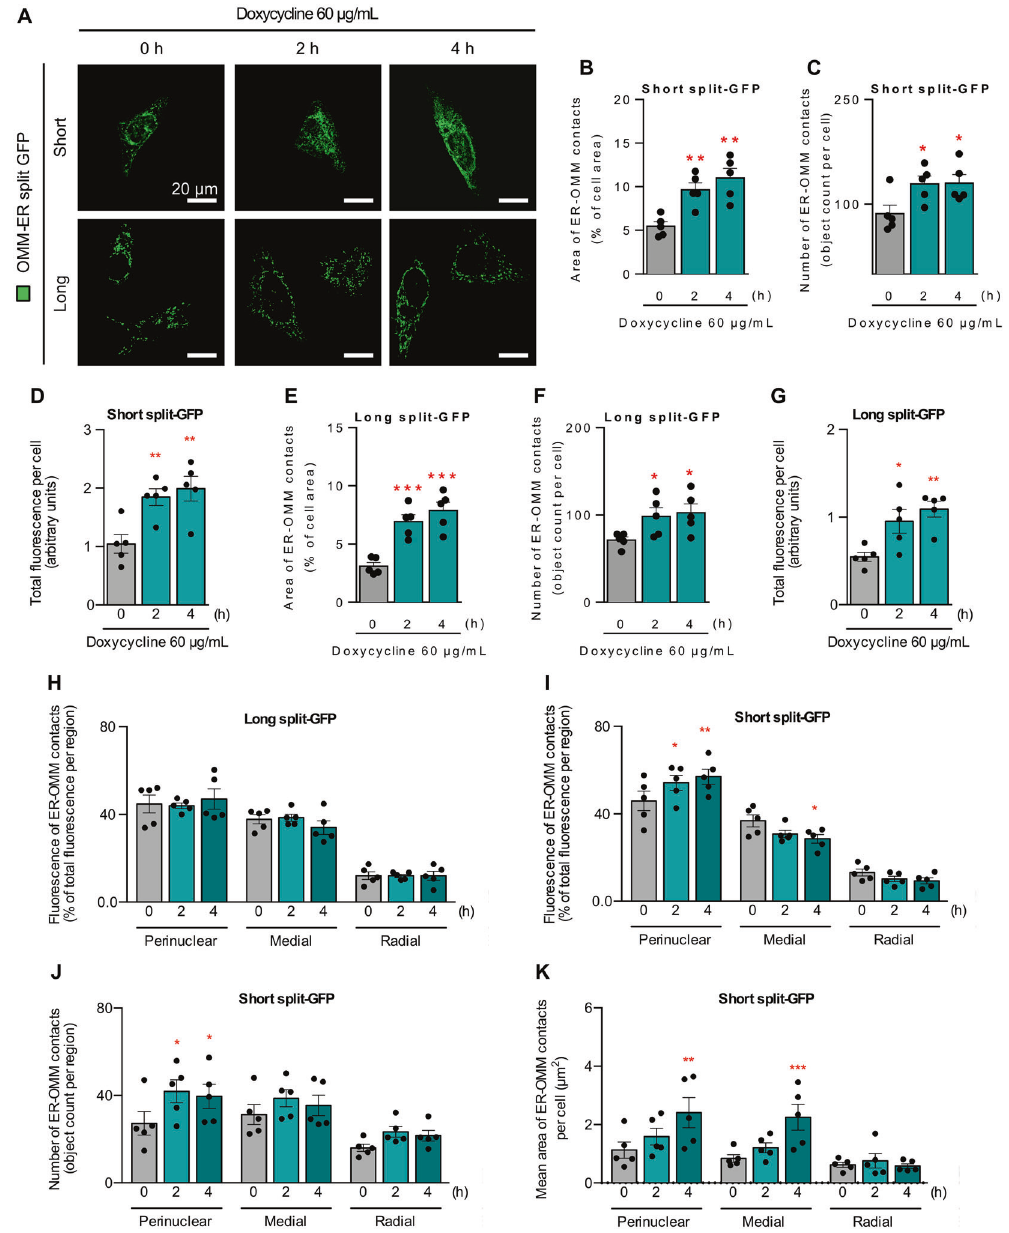
Fig. 2 Doxycycline increases early ER − mitochondria contacts. A HeLa cells were transfected with two ER-mitochondria split-GFP combinations of plasmids (OMM GFP β 1 – 10 + [ER GFP β 11 short or ER GFP β 11 long]) for 24 h, then treated with 60 µg/mL doxycycline for the indicated times and imaged using confocal microscopy. Scale bars: 20 µm. Quanti fi cation of split-GFP fl uorescence measured as the percentage of fl uorescent area versus total cell area ( B ), the number of fl uorescent objects ( C ) for short ER-mitochondria split-GFP, and ( D ) the total GFP fl uorescence intensity per cell ( n = 5). Quanti fi cation of split-GFP fl uorescence measured as the percentage of fl uorescent area versus total cell area ( E ), the number of fl uorescent objects ( F ) for long ER-mitochondria split-GFP, and ( G ) the total GFP fl uorescence intensity per cell ( n = 5). H, I Quanti fi cation of the total GFP fl uorescence intensity per cell in the prede fi ned subcellular regions for both long and short split- GFPs ( n = 5). Quanti fi cation of short split-GFP fl uorescence measured as the number of fl uorescent objects ( J ) and their size ( K ) in the prede fi ned subcellular regions ( n = 5). Results are shown as mean ± s.e.m. * P < 0.05, ** P < 0.01, and *** P < 0.001 and versus control not allow direct comparison of differences in the basal concentration of mitochondrial Ca 2 + or account for the differences in sensor expression from experiment to experiment under different condi- tions. For this reason, mitochondrial Ca 2 + uptake experiments were